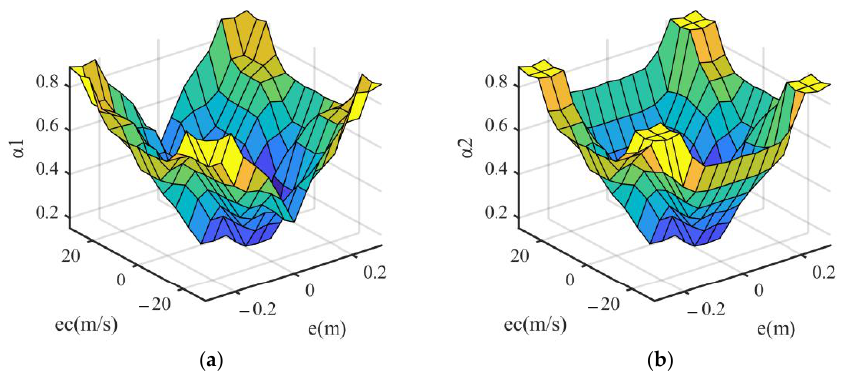
Figure 12. Mapping relationship between input variables and output variables of the fuzzy controller II. ( a ) Mapping of input variables to α 1 . ( b ) Mapping of input variables to α 2